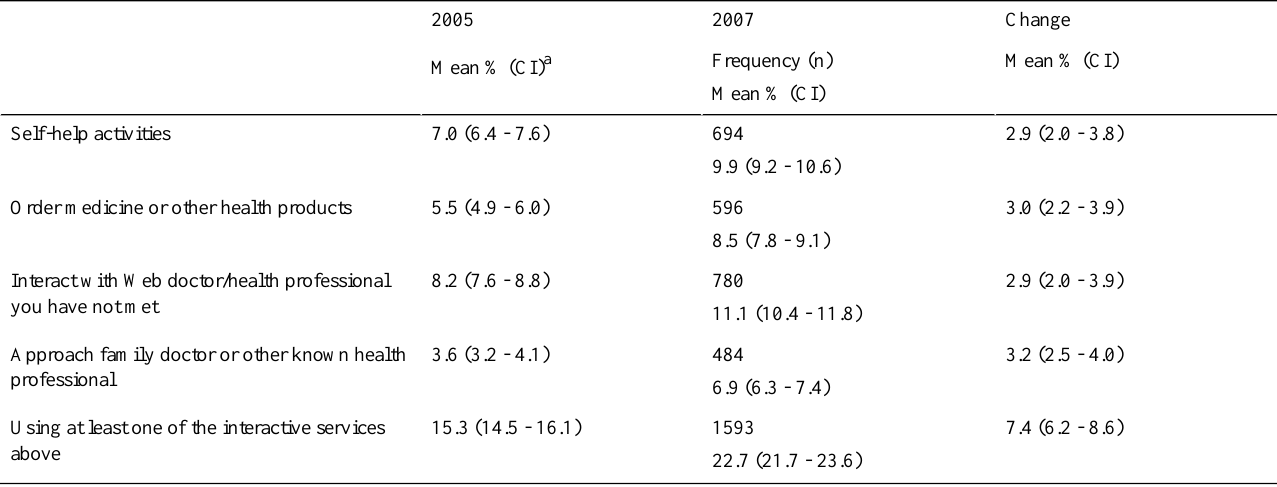
Table 3. Percentage of consumers who are using interactive Internet health services at least once a year (Multimedia Appendix 5 shows the percentages for Internet users and Internet health